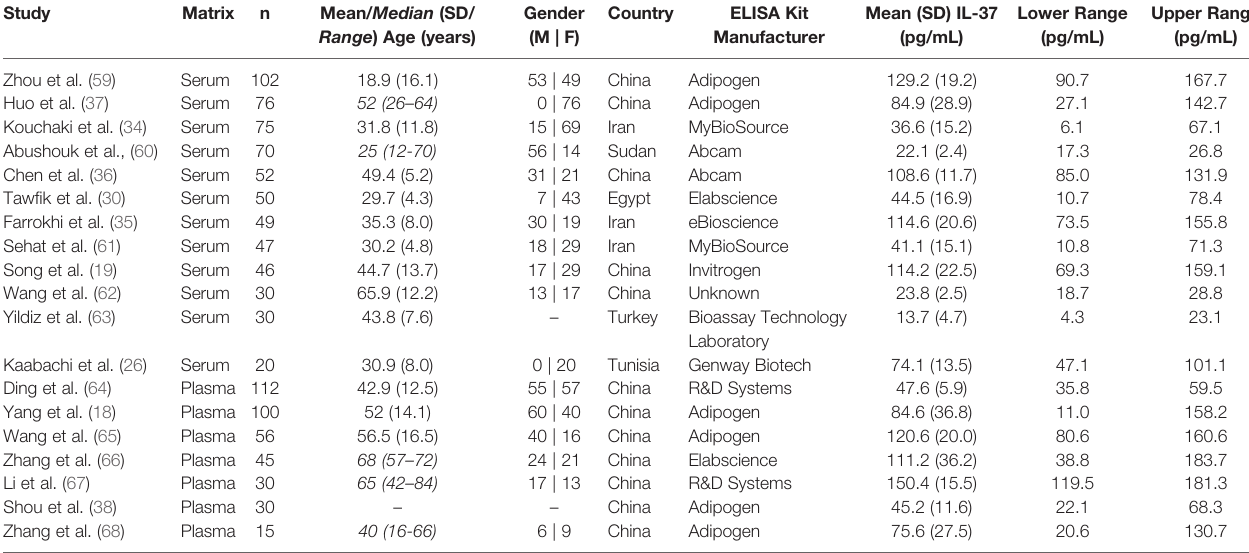
TABLE 1 | Description of studies included in the analysis, with healthy adult subject demographics, study-reported mean IL-37 levels, and computed healthy IL-37 level ranges. Study